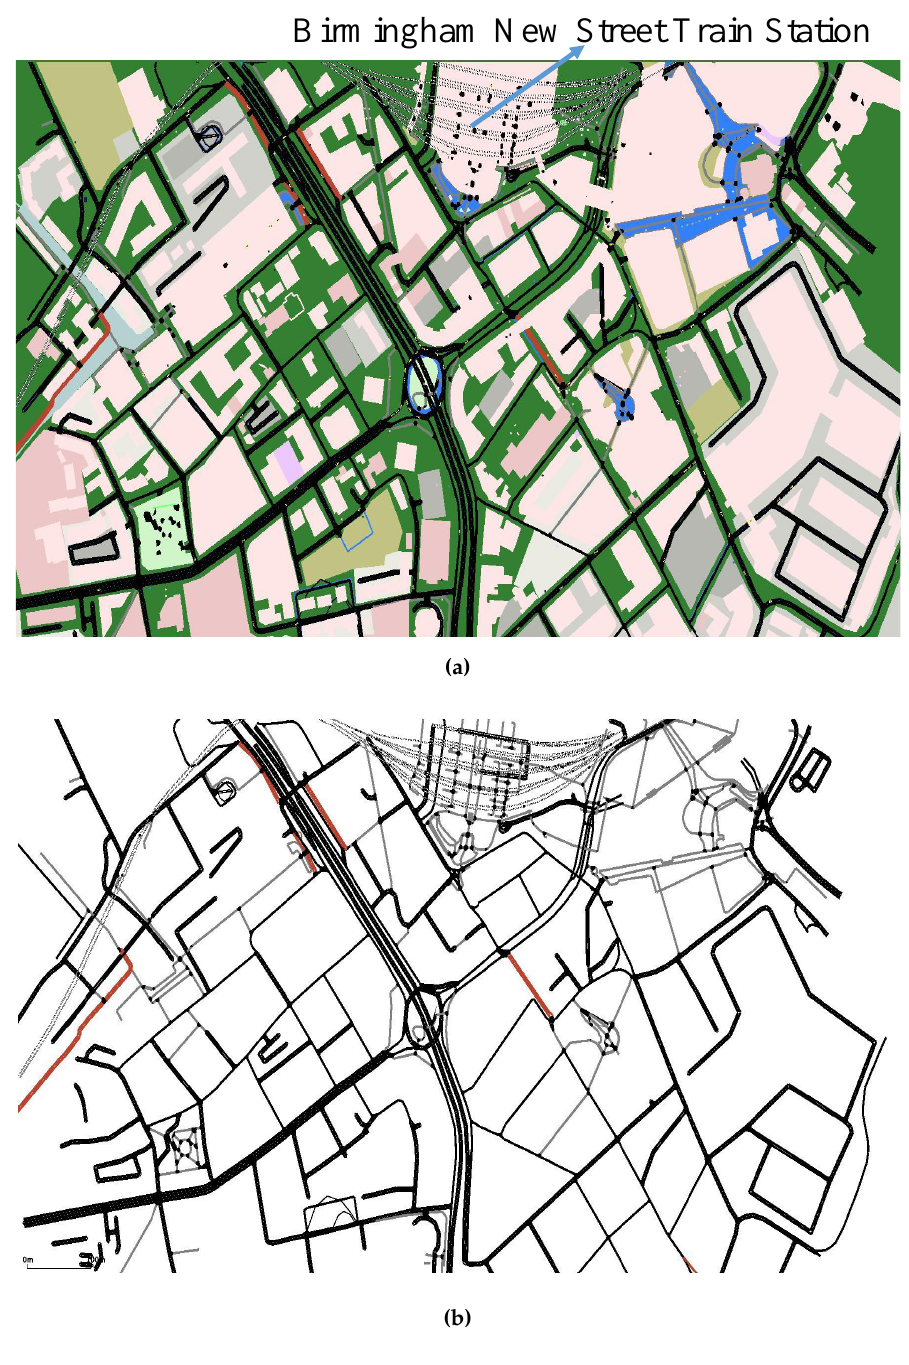
Figure 12. The section of Birmingham city centre and the SUMO map. ( a ) The section of Birmingham city centre under consideration; ( b ) The SUMO section of Birmingham city centre under